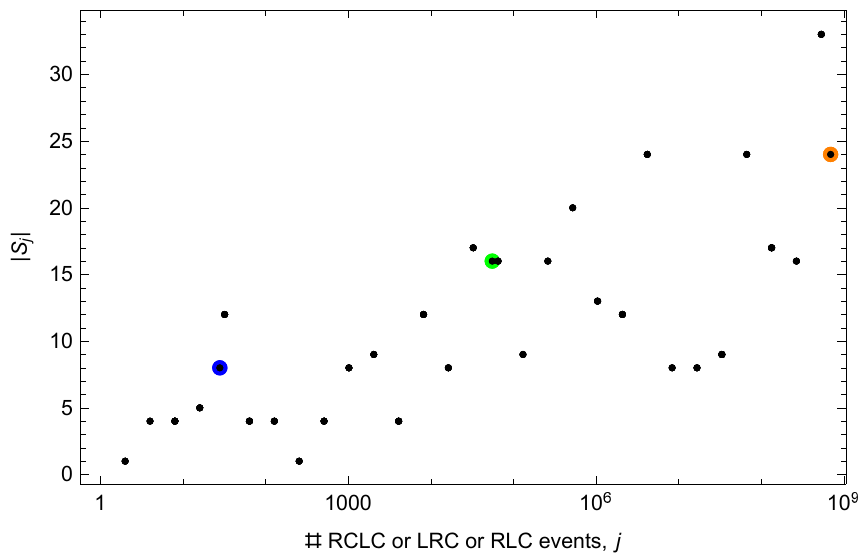
as a function of “time” j . We show 200 randomly chosen j at j (see (39) for Q = 1 and x j m = 0,1,2